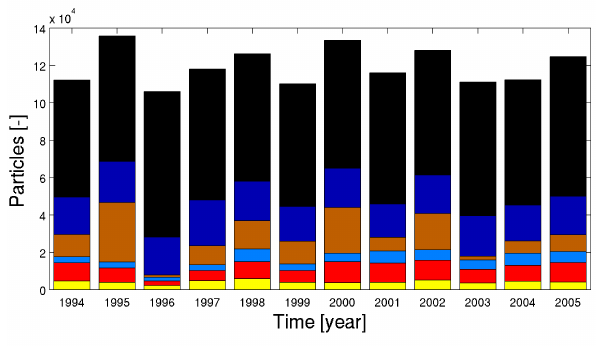
Figure 13. Numbers of particles settling in the different coastal zones for the different years: (dark blue) settlement in the North Sea coastal zone of the UK; (black) settlement in the English Chan- nel; (yellow) settlement along the French, Belgian and Dutch North Sea coast; (red) settlement in the western part of the Wadden Sea; (light blue) settlement in the northern part of the Wadden Sea; (or- ange) settlement outside of the shown domain (generally along the northern Danish and Norwegian coast).